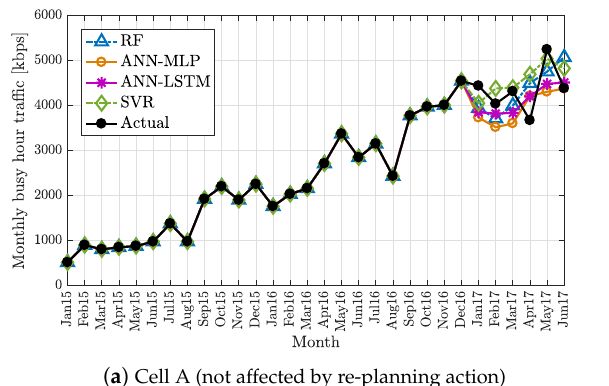
Figure 5. Example of the impact of re-planning actions on cell traffic.